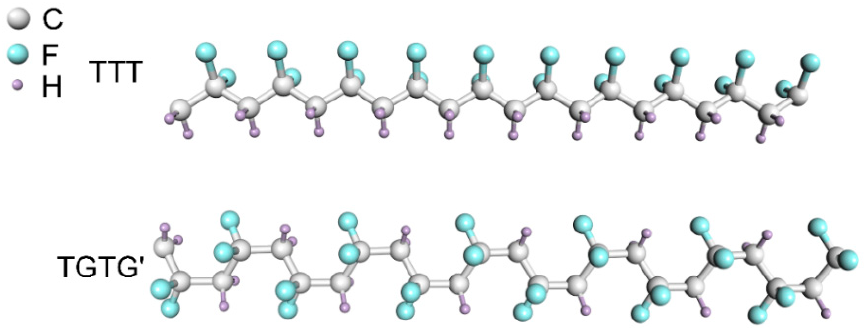
Figure 1. All-trans conformation (TTT) in α phase and helical conformation (TGTG’) in β phase. The TrFE (trifluoroethylene) and CTFE (chlorotrifluoroethylene) units are introduced into PVDF to obtain binary or terpolymers. Compared with the H atom, the F atom has a larger size, so the introduction of these units will produce greater steric hindrance, which will help the formation and stability of the all-trans chain structure ( β phase) [5,46]. These